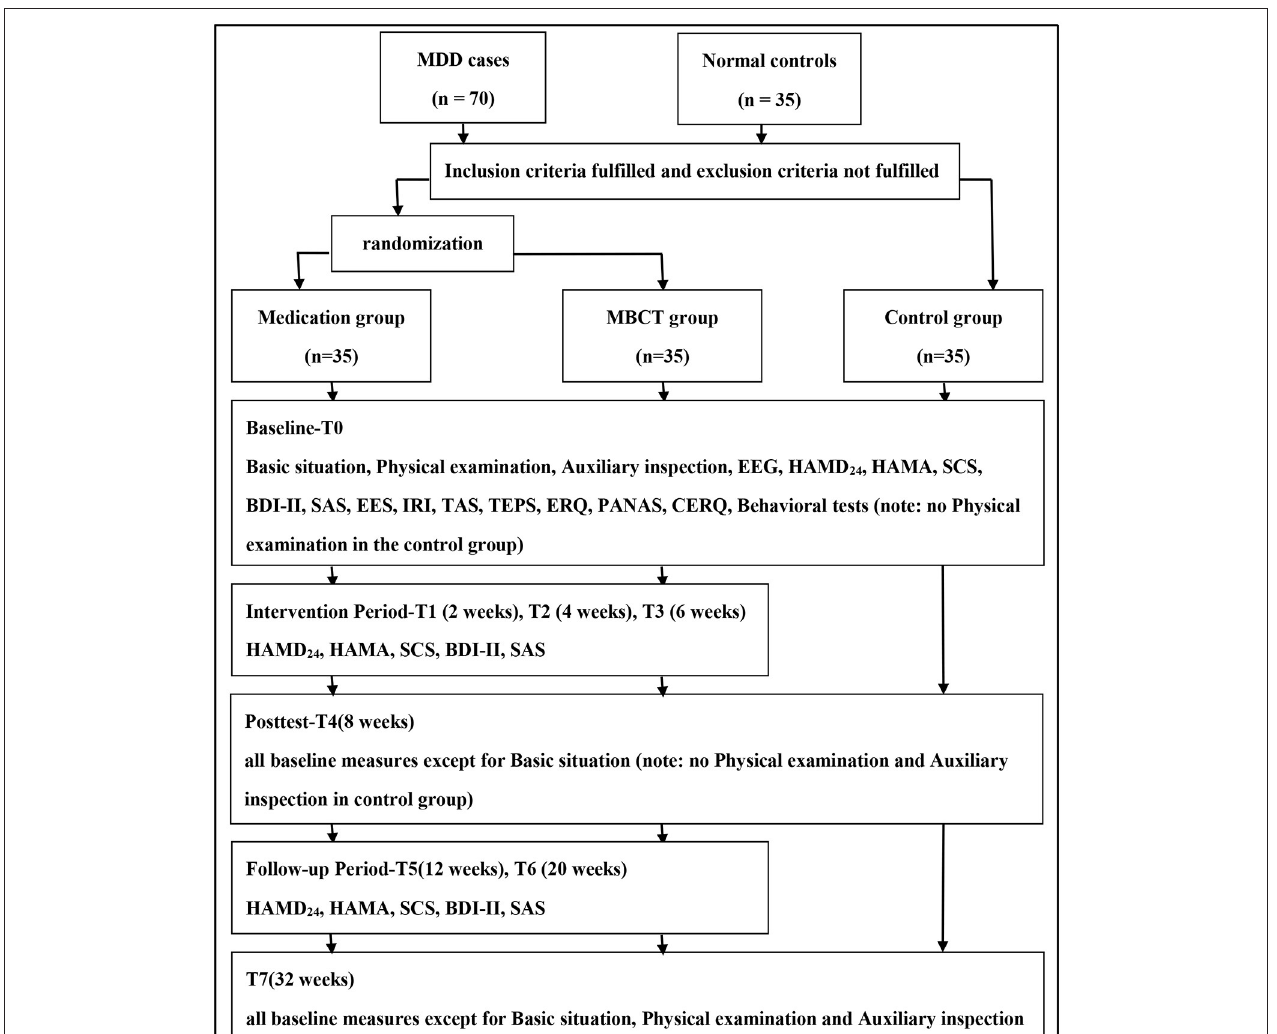
FIGURE 1 | Study design and measurement time points. EEG, electroencephalogram; HAMD24, Hamilton Depression Scale-24; HAMA, Hamilton Anxiety Scale; SCS, Self-Compassion Scale; BDI-II, Beck Depression Inventory-II; SAS, Self-rating Anxiety Scale; EES, Emotional Expressivity Scale; IRI, Interpersonal Reactivity Index; TAS, Toronto Alexithymia Scale; TEPS, Temporal Experience of Pleasure Scale; ERQ, Emotion Regulation Questionnaire; PANAS, Positive Affect and Negative Affect Scale, CERQ, Cognitive Emotion Regulation